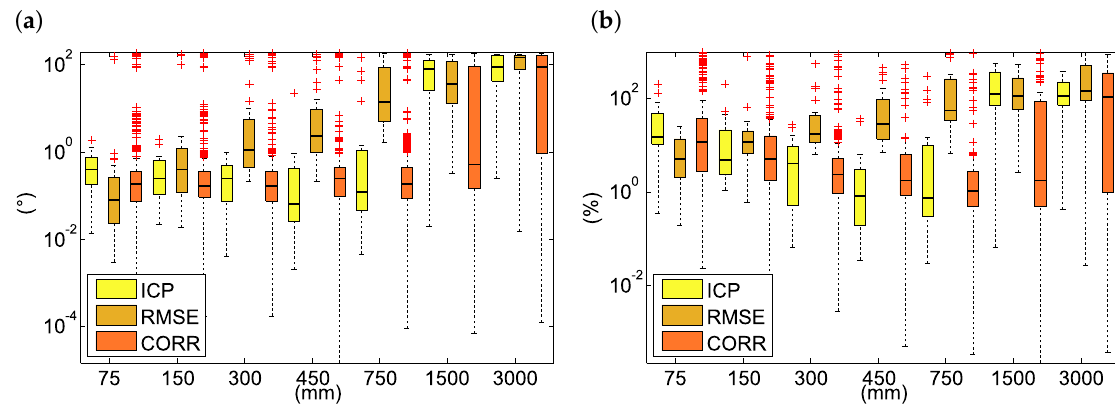
Figure 10. Absolute ( a ) and relative ( b ) rotation errors of scan matching experiments for laser range scans taken after robot movement of